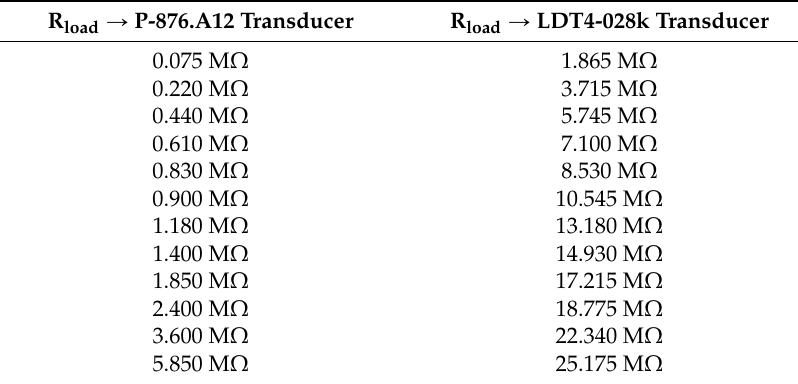
Table 5. The chosen fixed values of the resistors.